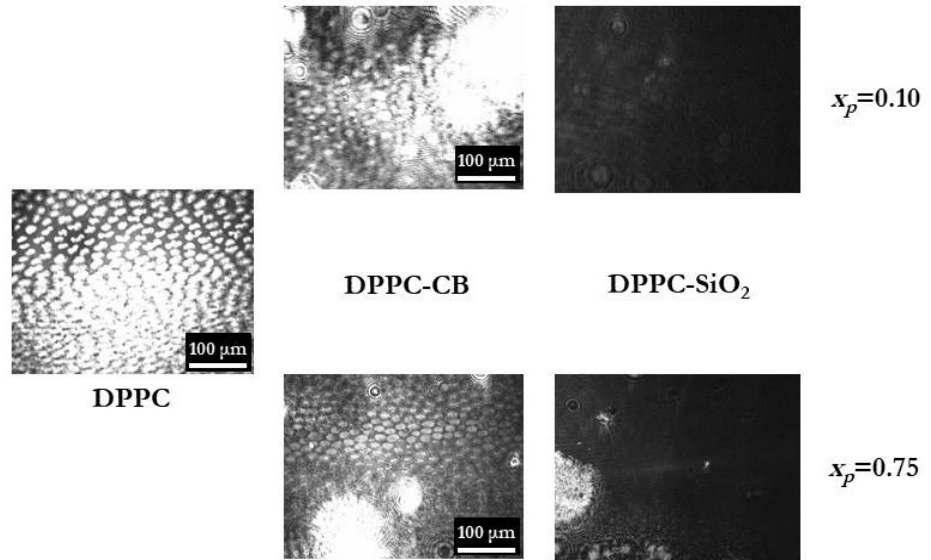
Figure 6. BAM images of DPPC monolayers upon the incorporation of CB and SiO 2 particles at two different values of x p for surface pressure about 7.5 mN/m, corresponding to the LE–LC phase coexistence.